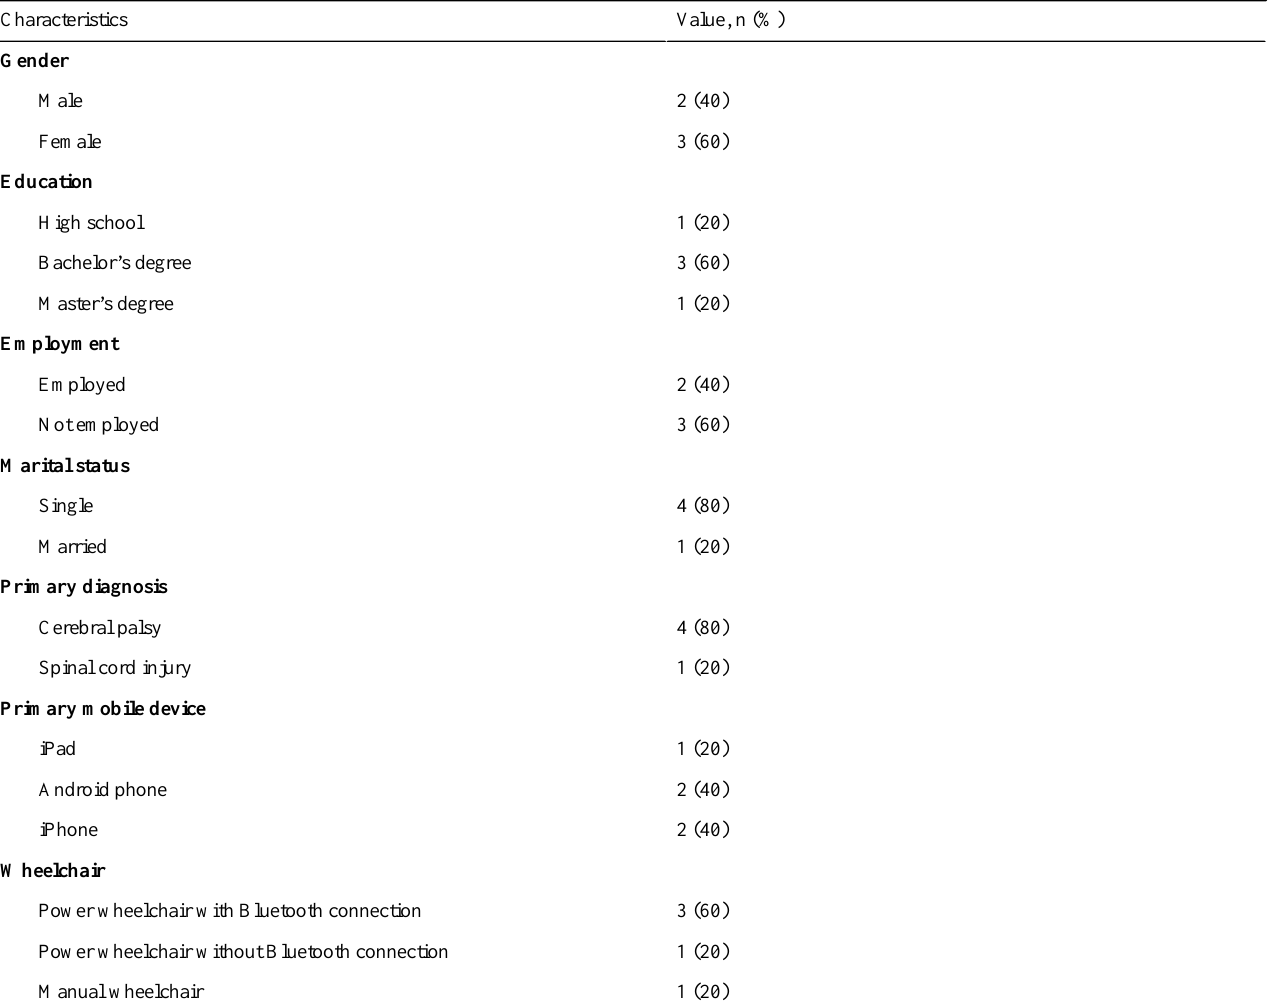
Table 1. Demographic characteristics of the study participants